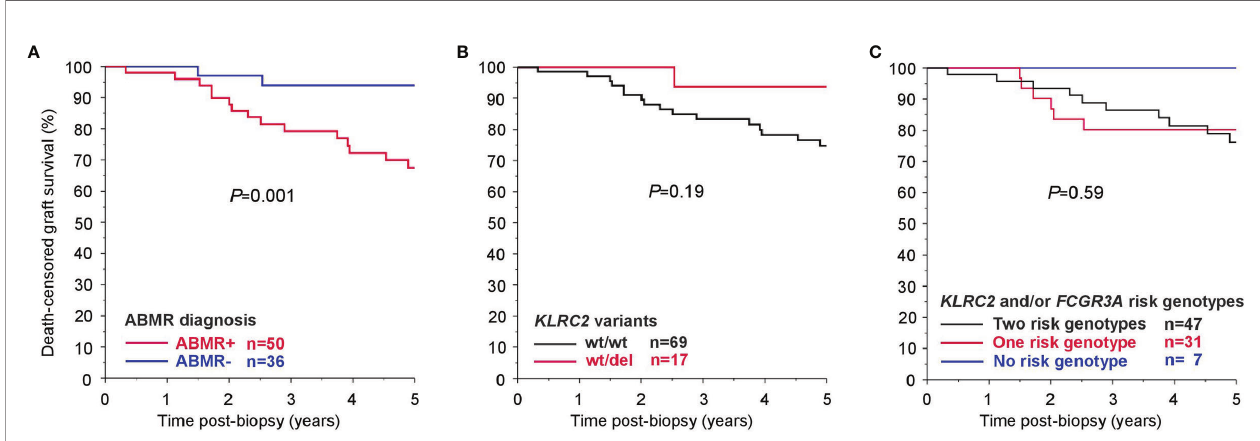
FIGURE 4 | Kaplan Meier death-censored graft survival in the DSA+ cohort (BORTEJECT) in relation to (A) antibody-mediated rejection (ABMR) diagnosis, (B) KLRC2 genotype ( KLRC2 wt/wt vs KLRC2 wt/del ), and (C) the number of NKG2C and Fc gamma receptor (Fc g R)IIIA ‘ risk genotypes ’ ( KLRC2 wt/wt ; FCGR3A -V/V158 or V/ F158), respectively.